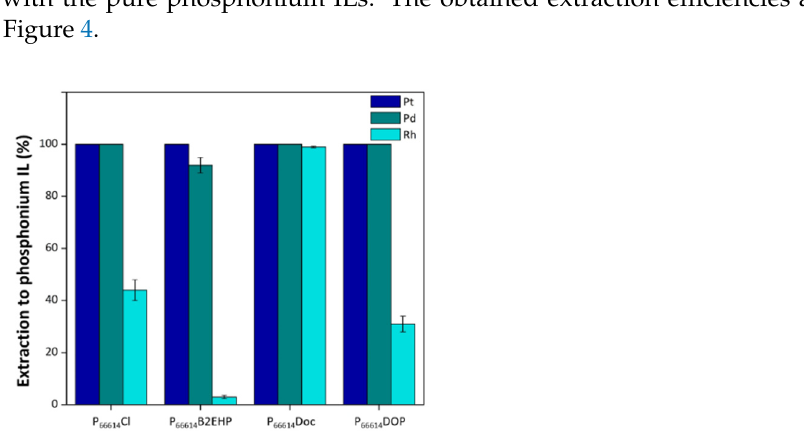
( b ) Figure 5. Extraction efficiencies (%) of PGMs to phosphonium ILs from PGM model, at 3.7 M HCl (left) and at 9.7 M HCl (right). 2.7. Application of Optimized Separation System to Authentic Car Catalyst Leachate Based on the optimization experiments performed with the model PGM solution, the optimum conditions that allow for maximum extraction of the PGM to the phosphonium